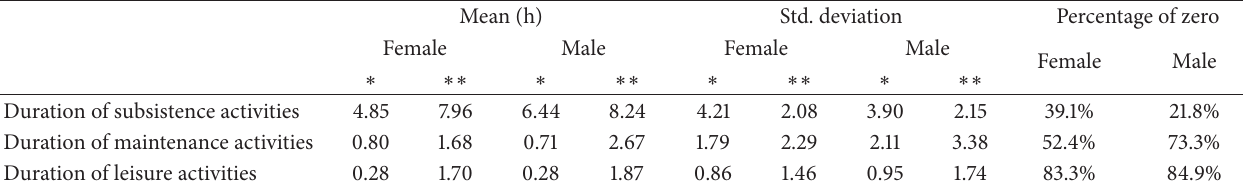
Table 2: Statistical descriptions of continuous independent variables.